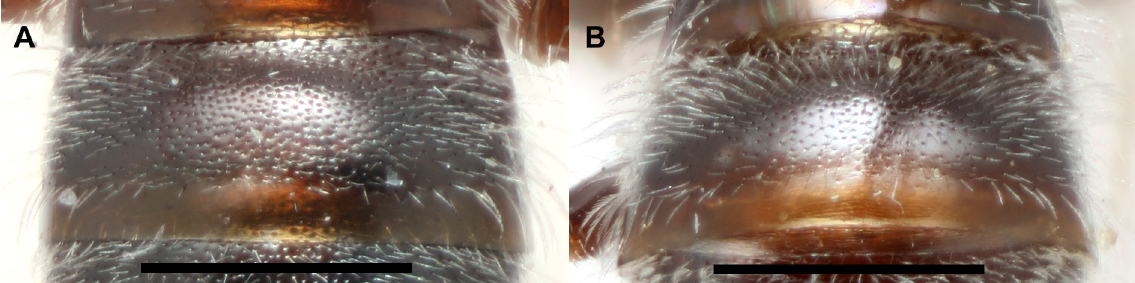
Fig. 117. T2. A . Lasioglossum egulare (Robertson, 1890), ♂, with dense punctures up to premarginal line sharply contrasting with impunctate apical rim. B . L. diabolicum sp. nov., ♂, with punctures becoming more sparsely punctate near and on premarginal line and not sharply contrasting with apical rim. Scale bars = 0.5